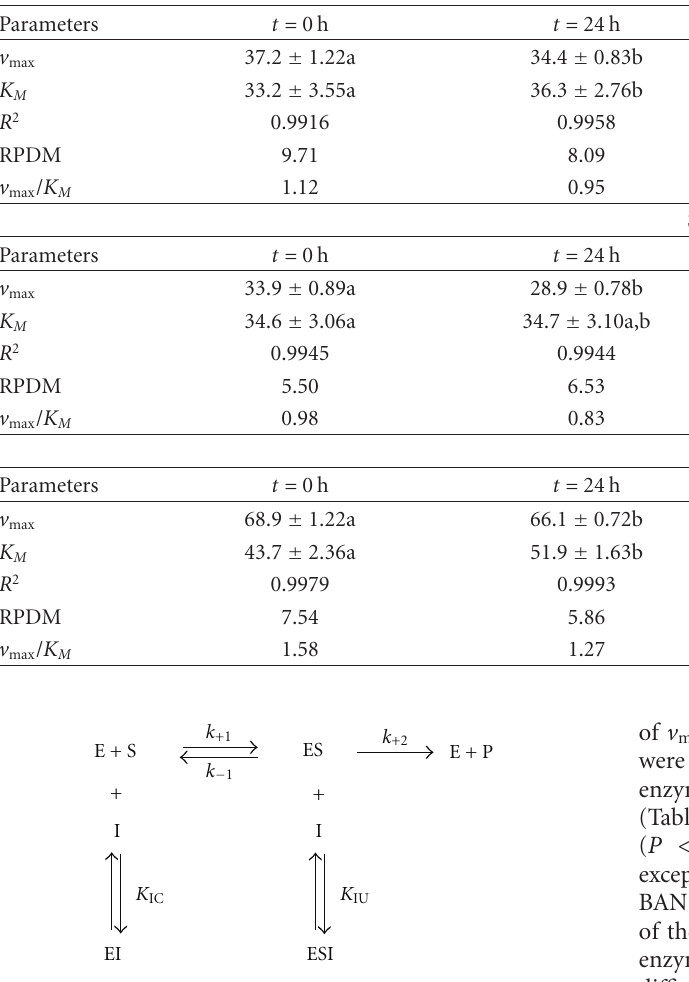
Figure 2: Scheme depicting the mixed competitive inhibition mechanism for the interaction of an inhibitor molecule ( I ) and an enzyme ( E ) in presence of substrate ( S ). k +1 , k − 1 , and k +2 are rate constants. K IC and K IU are, respectively, the competitive and the uncompetitive constants for the EI and ESI